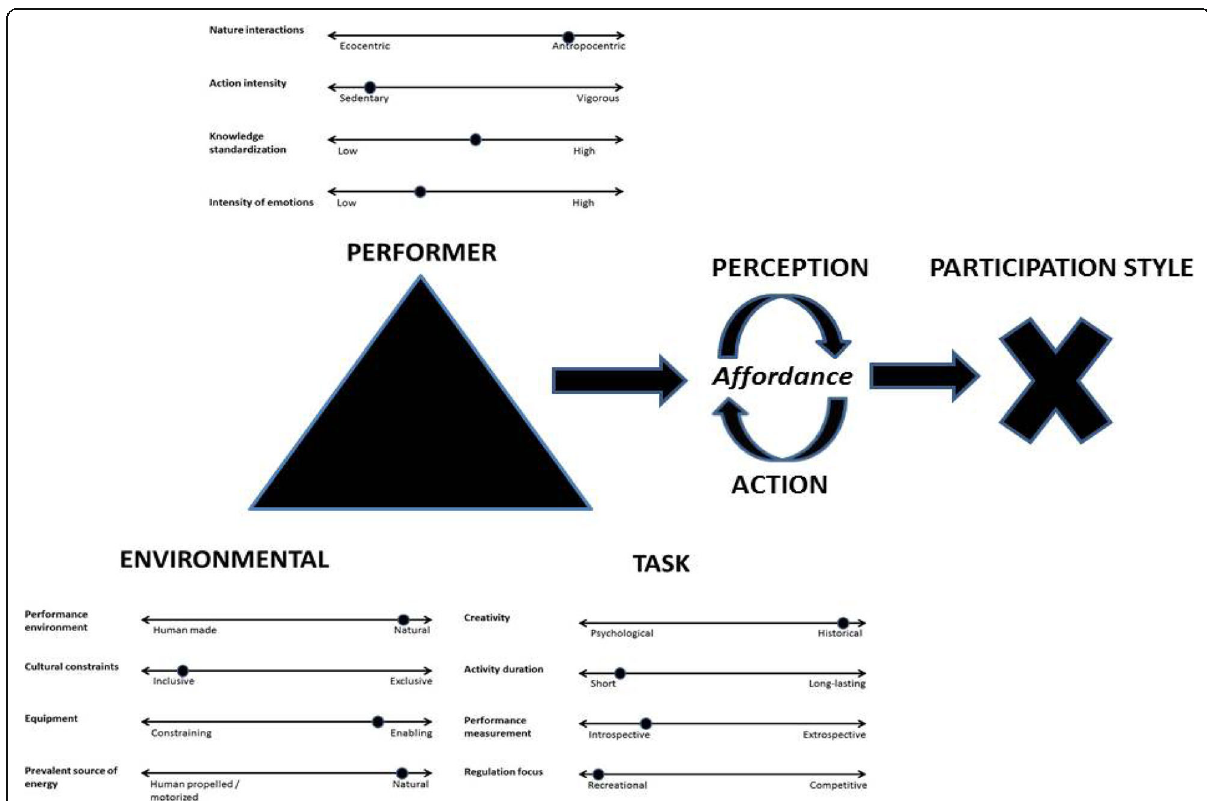
Fig. 1 Interacting constraints on action and adventure sports participation. Figure 1 was derived from ideas of Newell [54] and Davids, Button and Bennett [53]. Emerging, adaptive performer-environment relationships are scaled by situational and context-dependent key constraints that, in combination, define an AAS form of life/participation style. Due to the infinite combinations and complexity of interactions, irregular and unpredictable constraints are illustrated on continua, attending to significant situational and contextual fluctuations in each participant ’ s experience. Included in the figure are exemplary constraints, as reported in existing literature [16, 18, 21, 22, 25, 26, 29, 30, 34, 36, 45, 47, 63, 72 – 78], and varying characteristics and performance environments of AAS in their current states of development. For better understanding of AAS participation, new emerging constraints should be a posteriori included in the model according to complementary research findings and constant evolution of